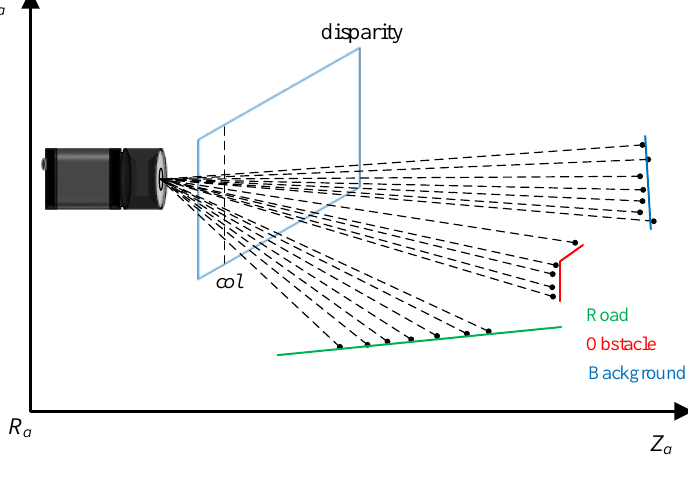
Figure 4. Score Figure 4. Score image.